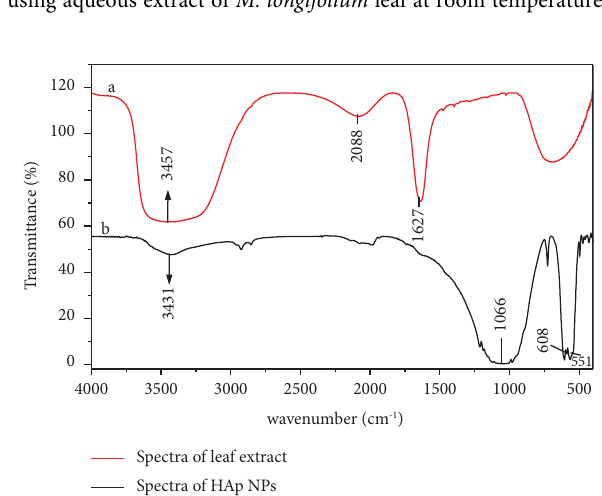
Figure 2: (a) FT-IR spectrum of the aqueous extract of M. longifolium leaf and (b) HAp